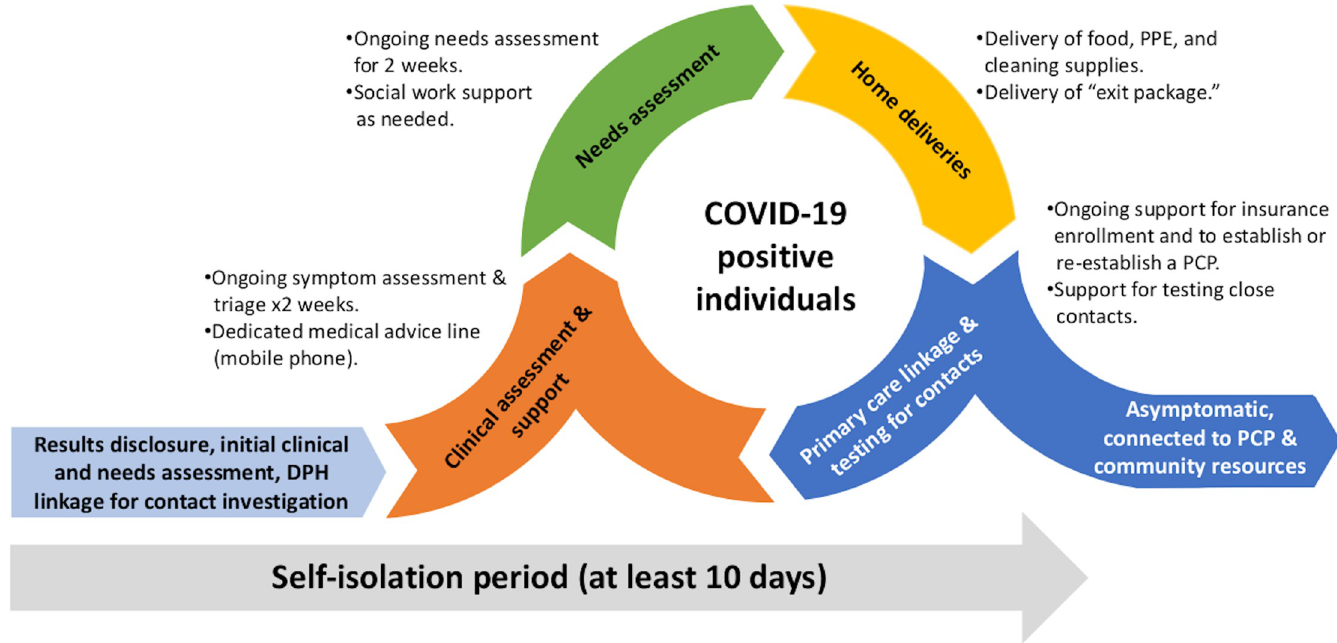
Fig 1. Overview of the Test-to-Care